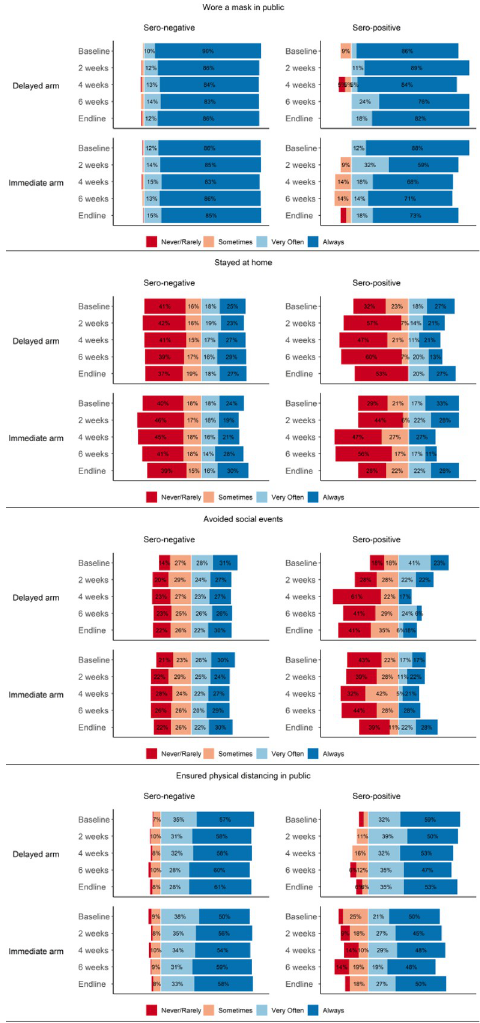
Fig 2. Protective behaviors by baseline sero-status in delayed and immediate randomized